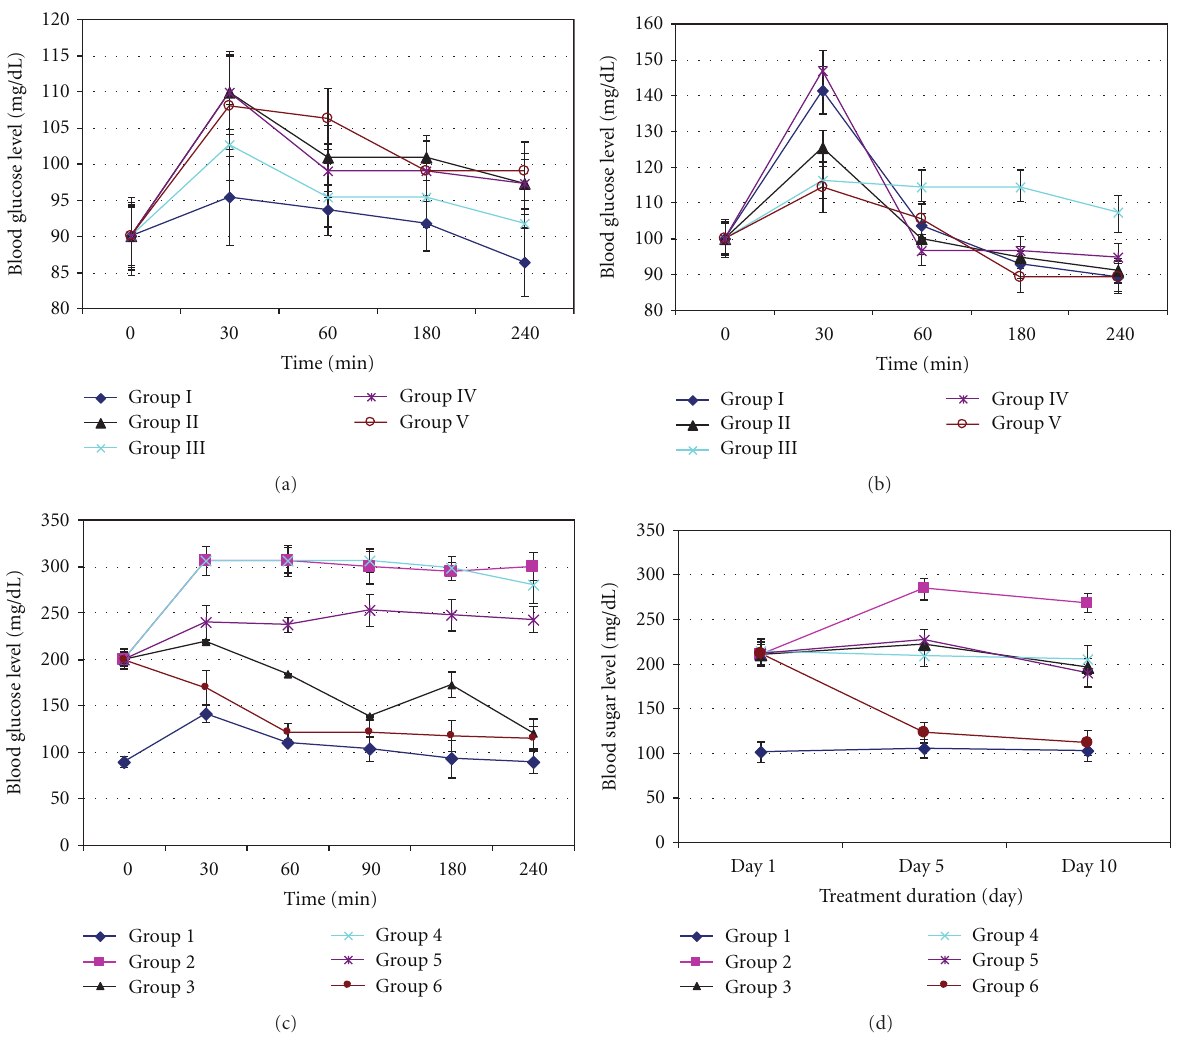
Figure 1: E ff ect of fermented, nonfermented mung bean and M. charantia extracts on (a) normoglycemic mice, (b) glucose-induced hyperglycemic mice, (c) alloxan-induced hyperglycemic mice, and (d) alloxan-induced hyperglycemic mice after 10 days of treatment. Grouping for (a) and (b) are Group I: normal control; Group II: M. charantia extracts (200mg/kg); Group III: normal + nonfermented mung bean extracts (1000 mg/kg); Group IV: fermented mung bean extracts (200mg/kg); Group V: fermented mung bean extracts (1000 mg/kg) while grouping for (c) and (d) are Group 1: normal control; Group 2: diabetic control; Group 3: diabetic + M. charantia extracts (200mg/kg); Group 4: diabetic + nonfermented mung bean extracts (1000mg/kg); Group 5: diabetic + fermented mung bean extracts (200mg/kg); Group 6: diabetic + fermented mung bean extracts